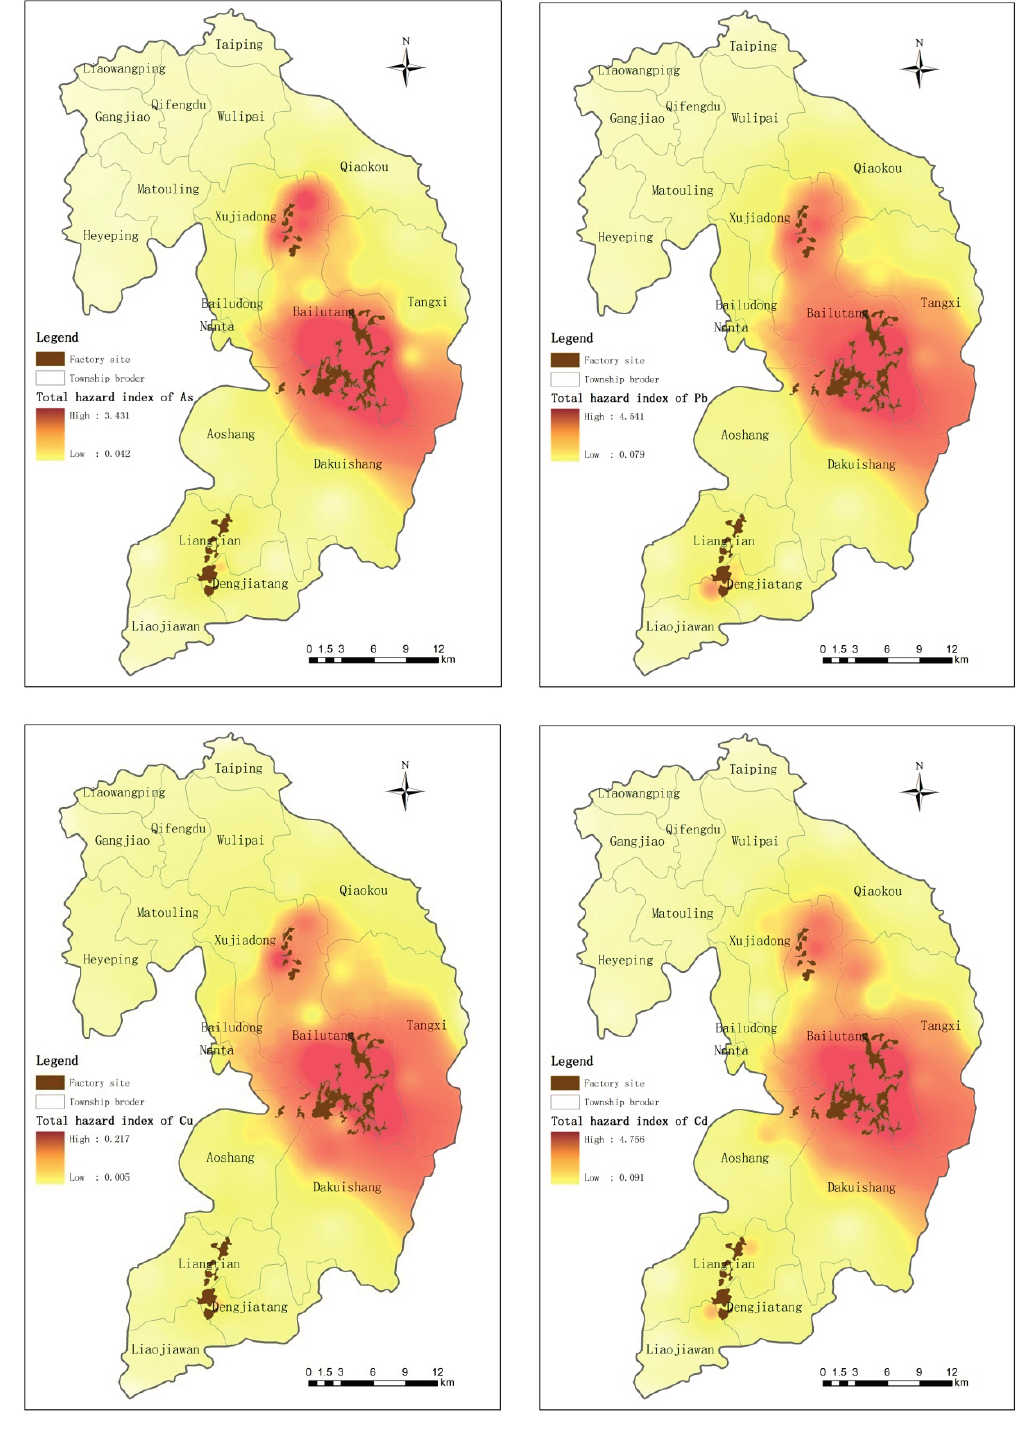
Figure 4. Geographical distribution of As, Pb, Cu and Cd non-carcinogenic risk indices in the study